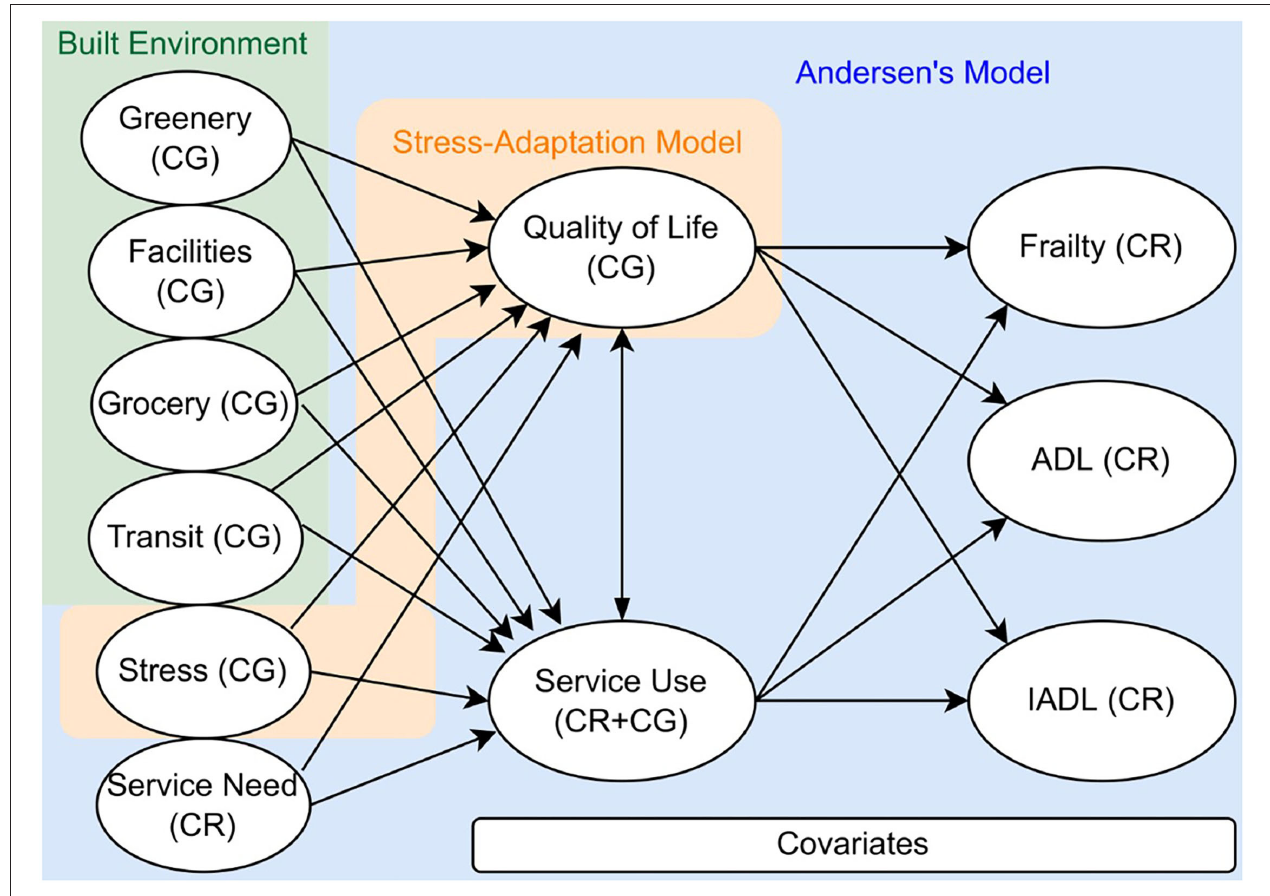
FIGURE 1 | Conceptual